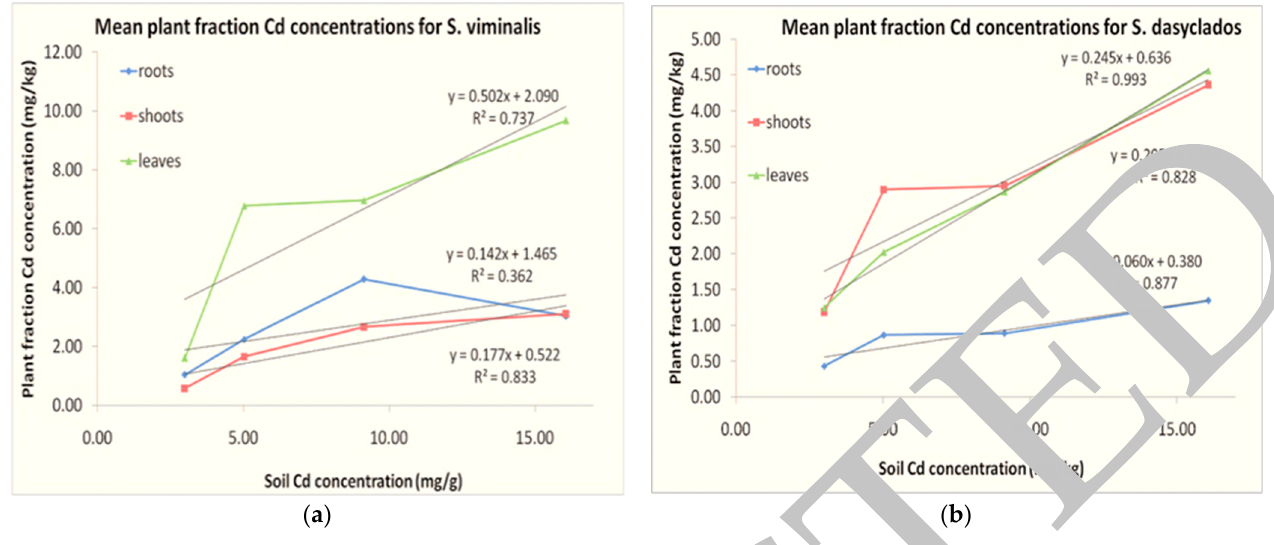
Figure 5. Mean plant fraction Cd concentrations as a function of soil contamination level showing trendline equations and R 2 values for S. dasyclados ( a ) and S. viminalis ( b ).